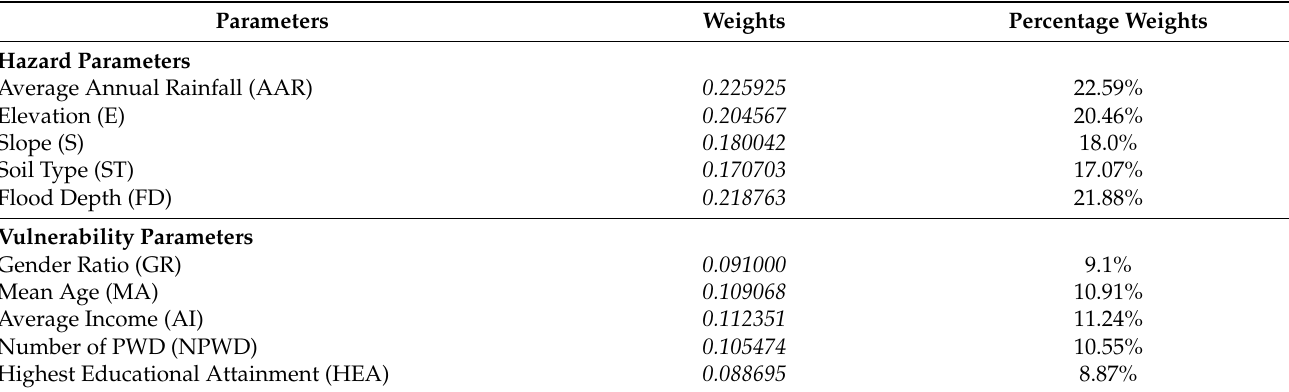
Table 8. Final weights and percentage weights of every parameter for hazard, vulnerability, and